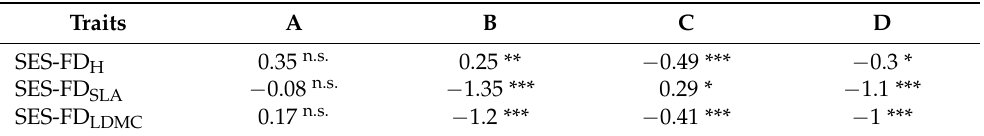
Table 3. Results of the two-tailed t -test assessing the standardized effect size of functional diversity per trait (SES-FD H : plant height; SES-FD SLA : specific leaf area; SES-FD LDMC : leaf dry matter content) and plant community (A: Leucopoa dimorpha community, B: Sesleria juncifolia community, C: Plantago atrata community, D: Silene acaulis community). Statistical significance of t -test is also reported (n.s.